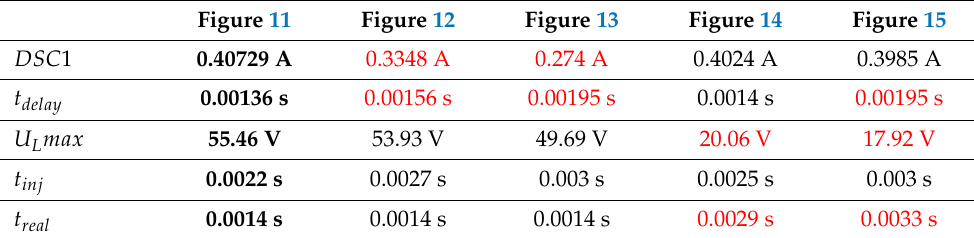
Table 1. Compilation of the most significant results from Figures